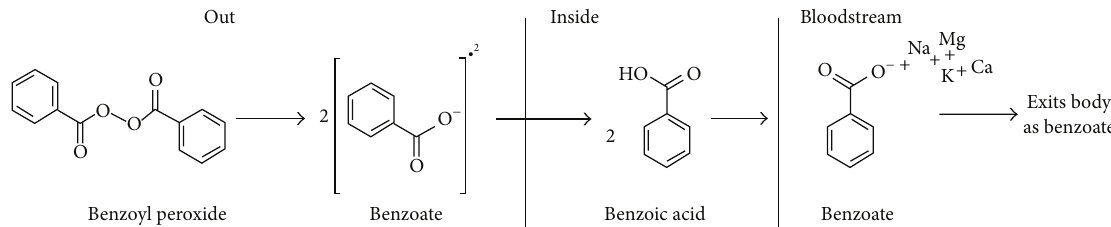
Figure 1: The breakdown of BPO upon contact with epithelium. BPO undergoes a homolytic fission resulting in two benzoate radicals which pass into the bloodstream where it is protonated into benzoic acid then deprotonated. Free cations in the blood will be attracted, but no further modifications will occur while in the